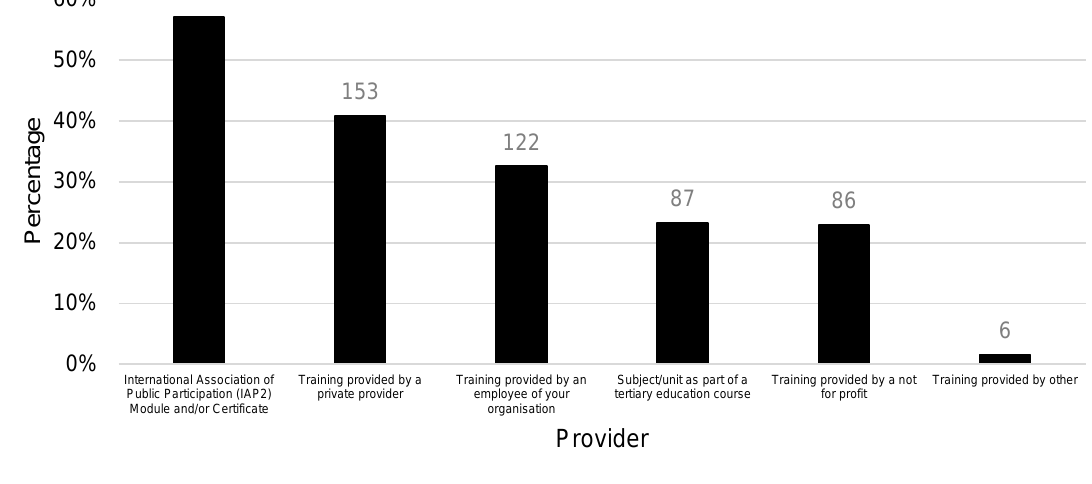
Figure 5. Training and short courses attended by participatory and deliberative practitioners in previous 10 years (n=334).